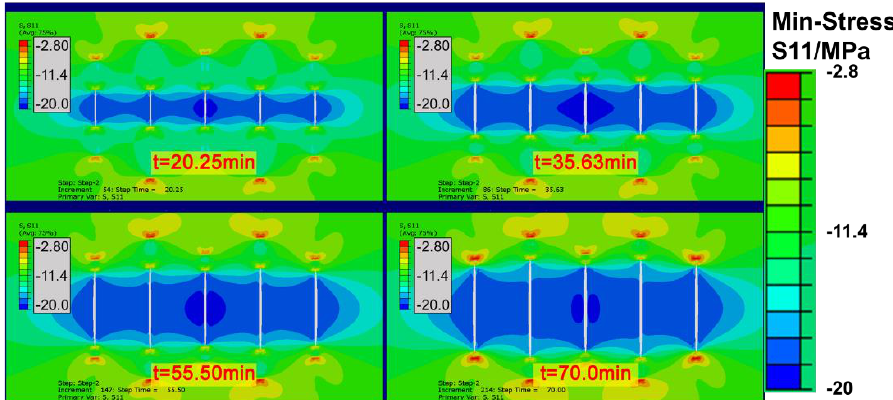
Figure 10. Results of in situ refracturing. The four figures show the fracture morphology and stress field distribution at different times during the refracturing process. After pumping (70 min), the morphology of the five fractures in the in situ refracturing is more uniform than that of initial fracturing.